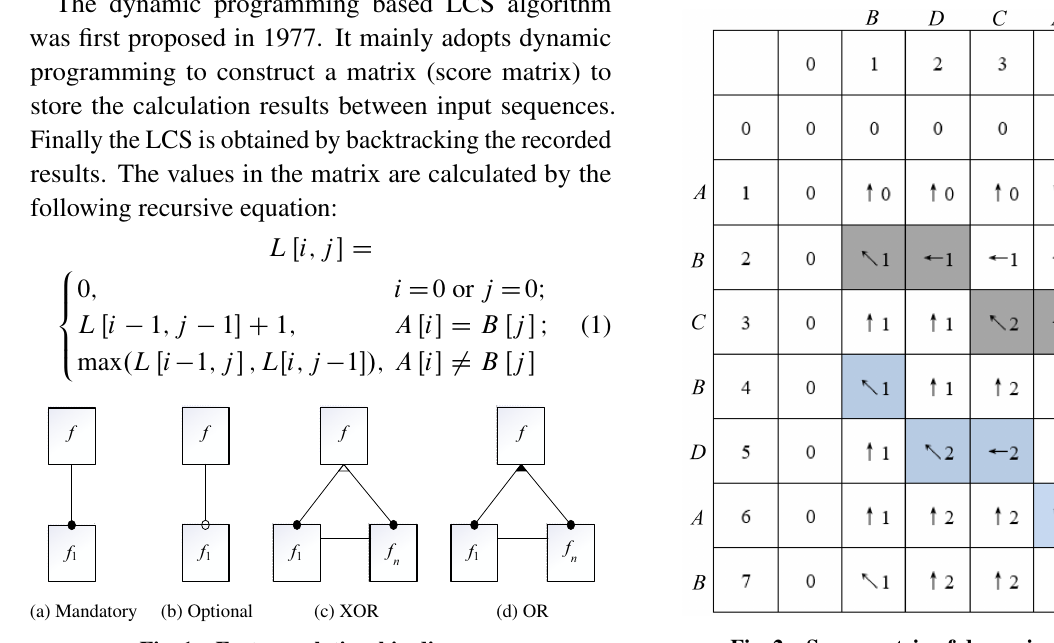
Fig. 1 Feature relationship diagram. Fig. 2 Score matrix of dynamic